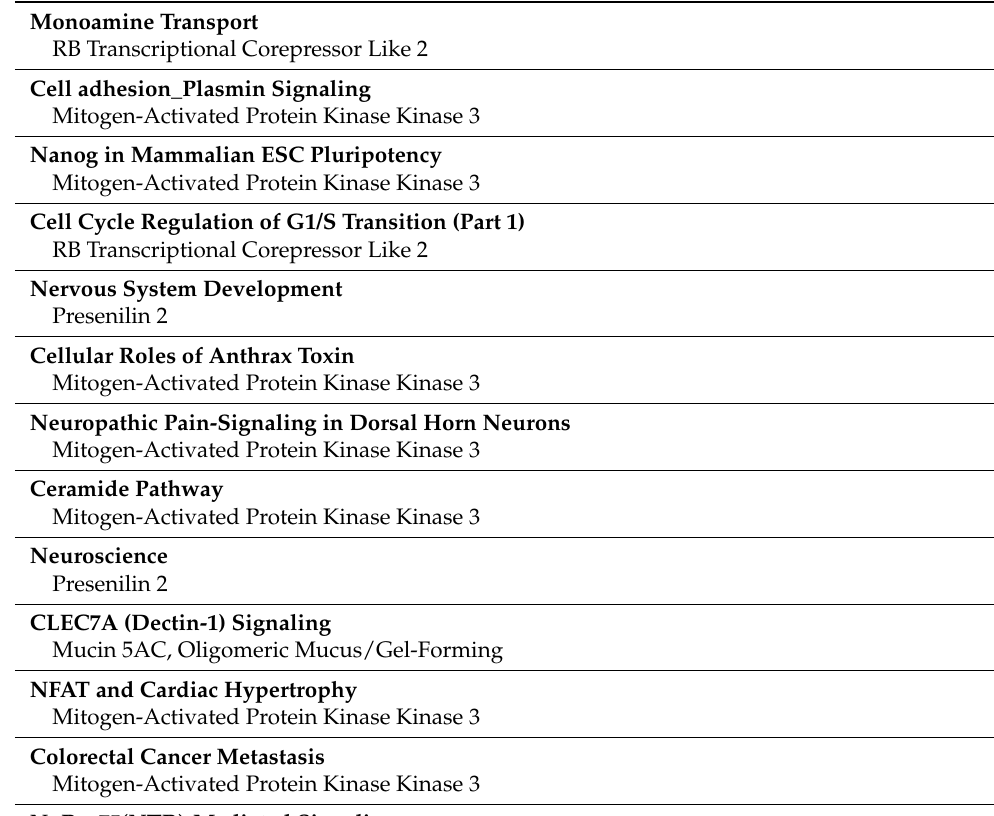
Table A2. Cont. Monoamine